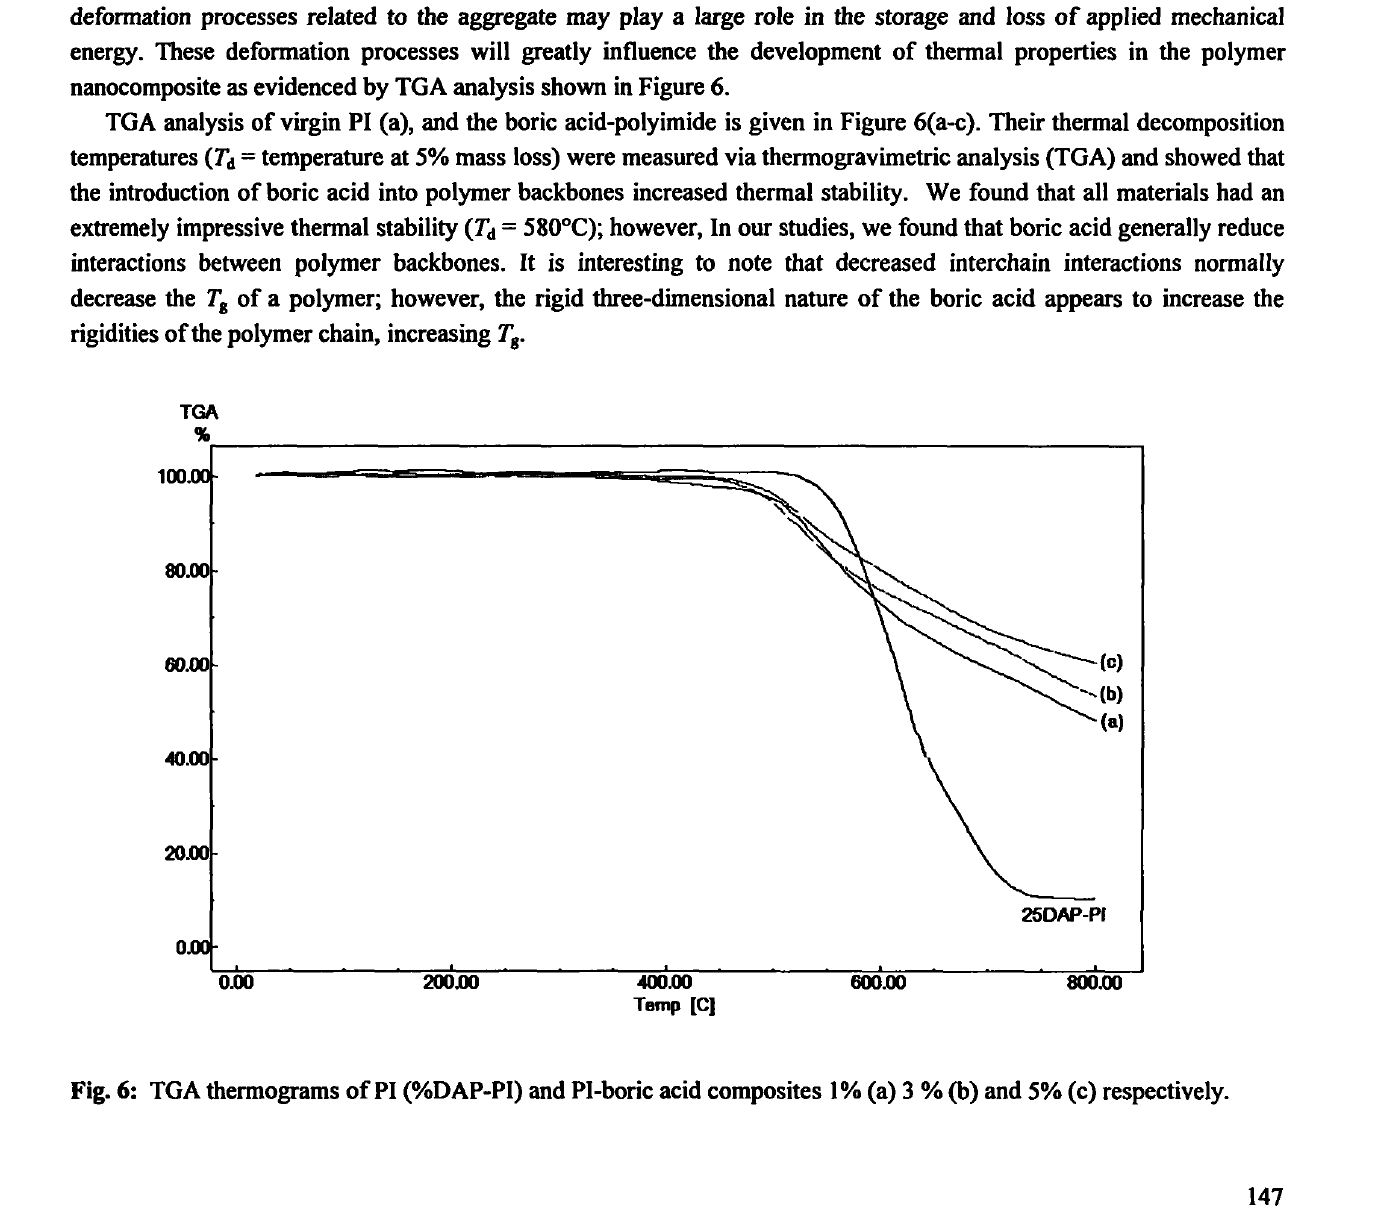
Fig. 6: TGA thermograms of PI (%DAP-PI) and Pi-boric acid composites 1% (a) 3 % (b) and 5% (c)